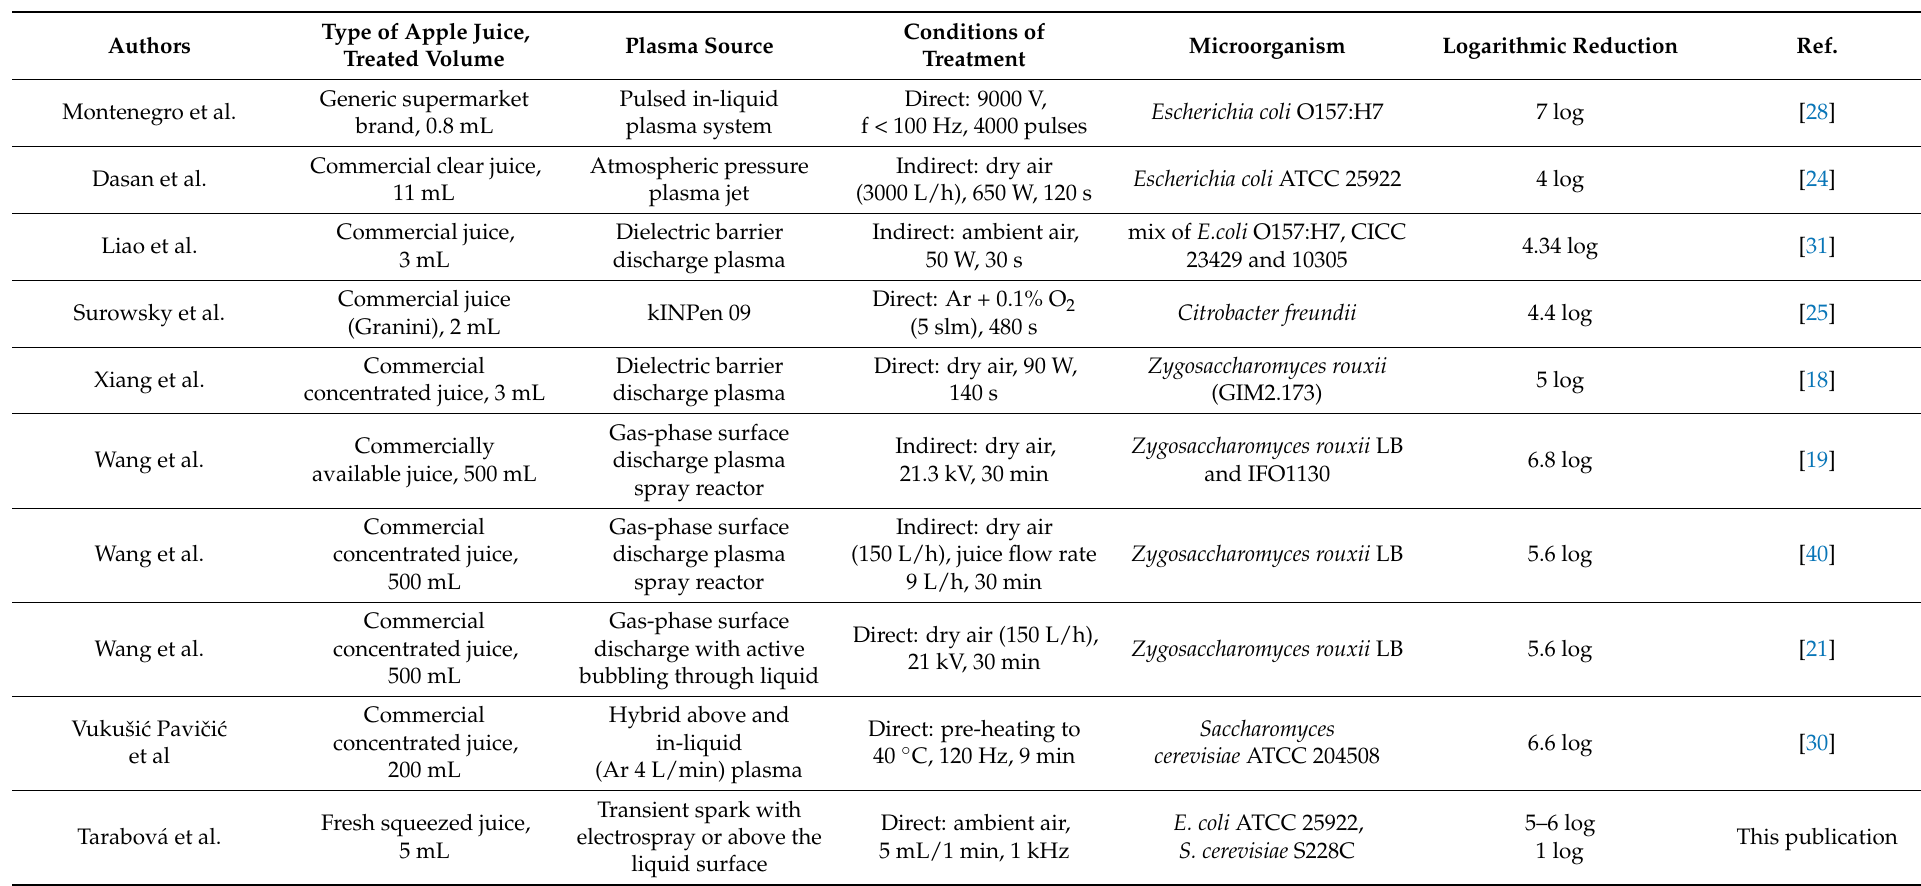
Table 4. Summary of the experimental studies that focused on the inactivation of microbes in apple juices using cold plasma, showing the types and conditions of the plasma treatment with the highest obtained antimicrobial